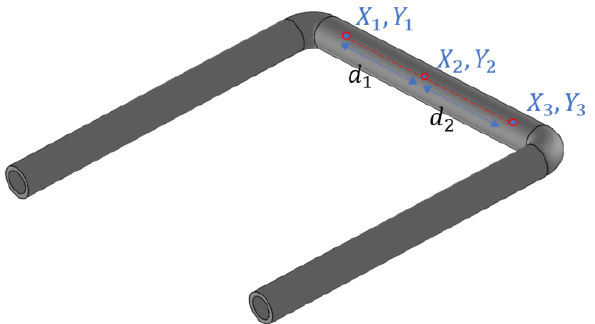
Figure 2. A U-shaped tube with three measurement points. There is no need for the second point (𝑋 2 ,𝑌 2 ) to be in the exact center of the tube.